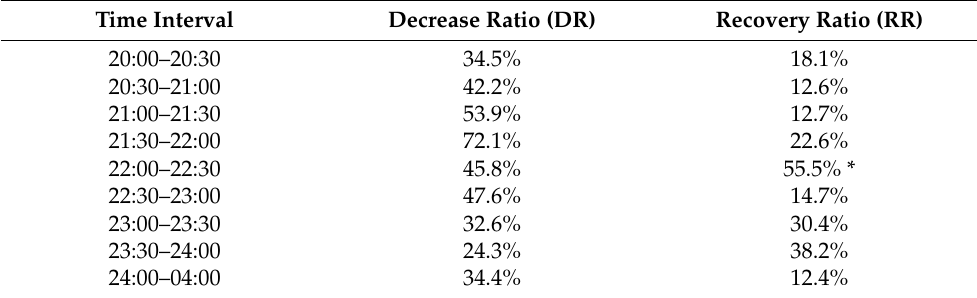
Table 4. The decrease ratio (DR) and recovery ratio (RR) of night-time skyglow at each time interval during the COVID-19